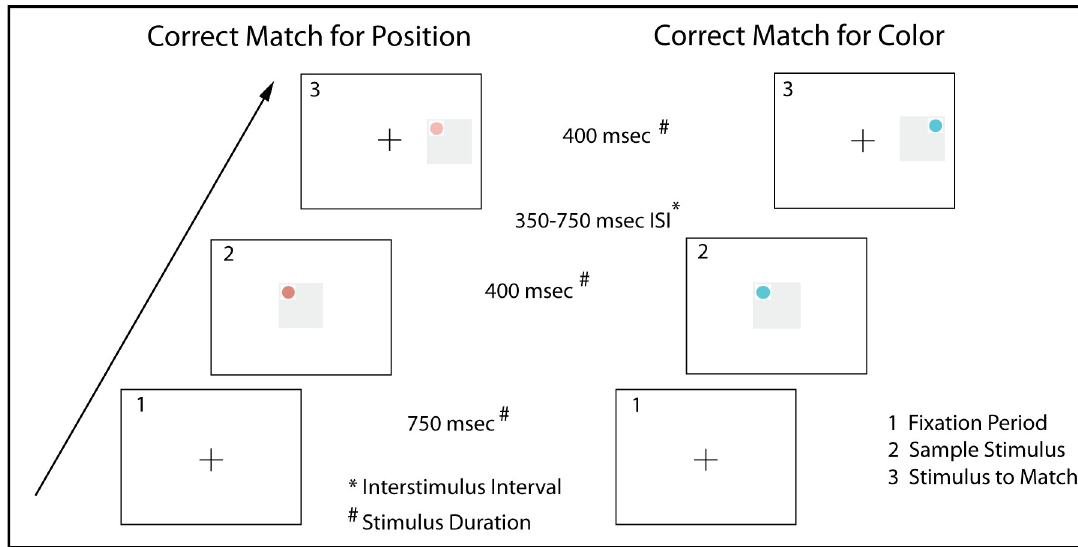
Fig 2. Flow chart for Experiment 1. The chart shows two possible correct answers that depend on the directions given. The sample trial on the left demonstrates matching the stimuli by position. The sample trial on the right demonstrates matching the stimuli by color. Panel 1 represents a fixation period where a plus sign was shown for 750 msec followed by a presentation of the stimulus for 400 msec in panel 2. There is a variable inter-stimulus of 350–750 msec followed by the target stimulus presentation for 400 msec, as represented in panel 3. Participants initiated a left hand response for a match and a right hand response for a mismatch.